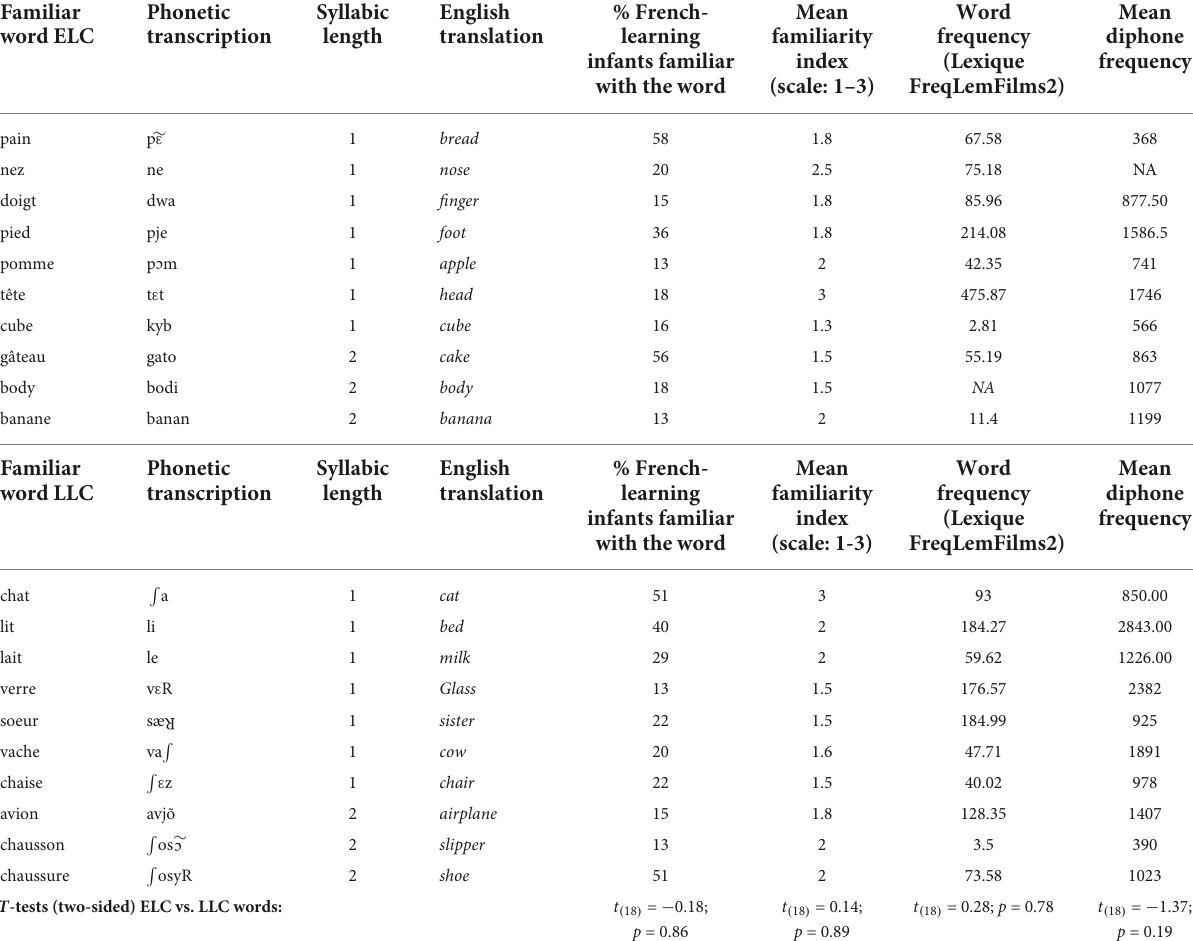
TABLE 1 Test stimuli used in experiment 1: familiar words containing early vs. late-learned consonants (ELC; LLC).